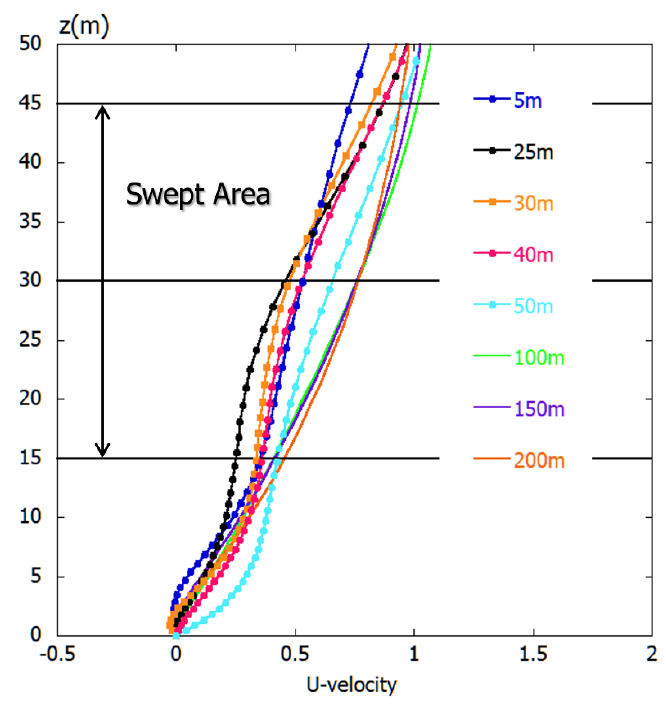
Figure A6. Comparison of nondimensional mean velocity profiles at WT #7 for north-westerly wind.